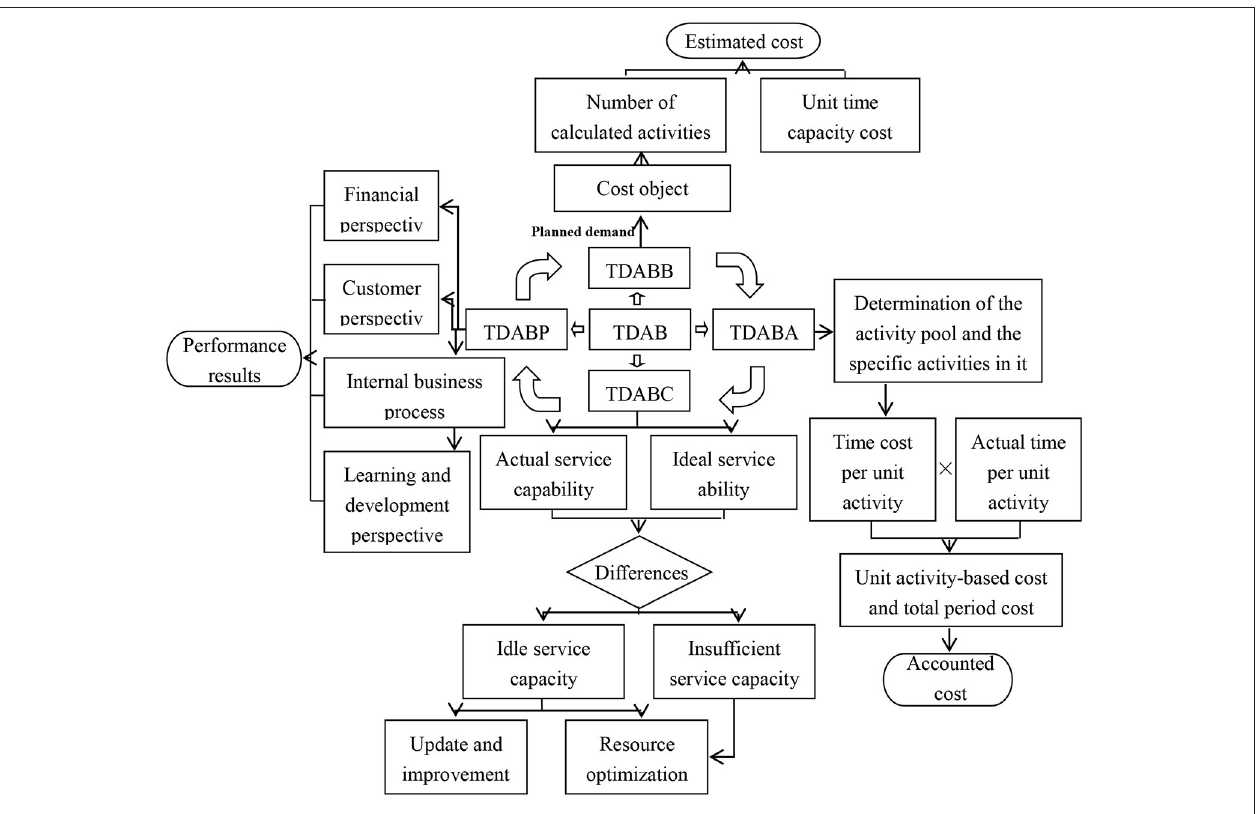
FIGURE 1 | The TDABM system of Grade-A tertiary